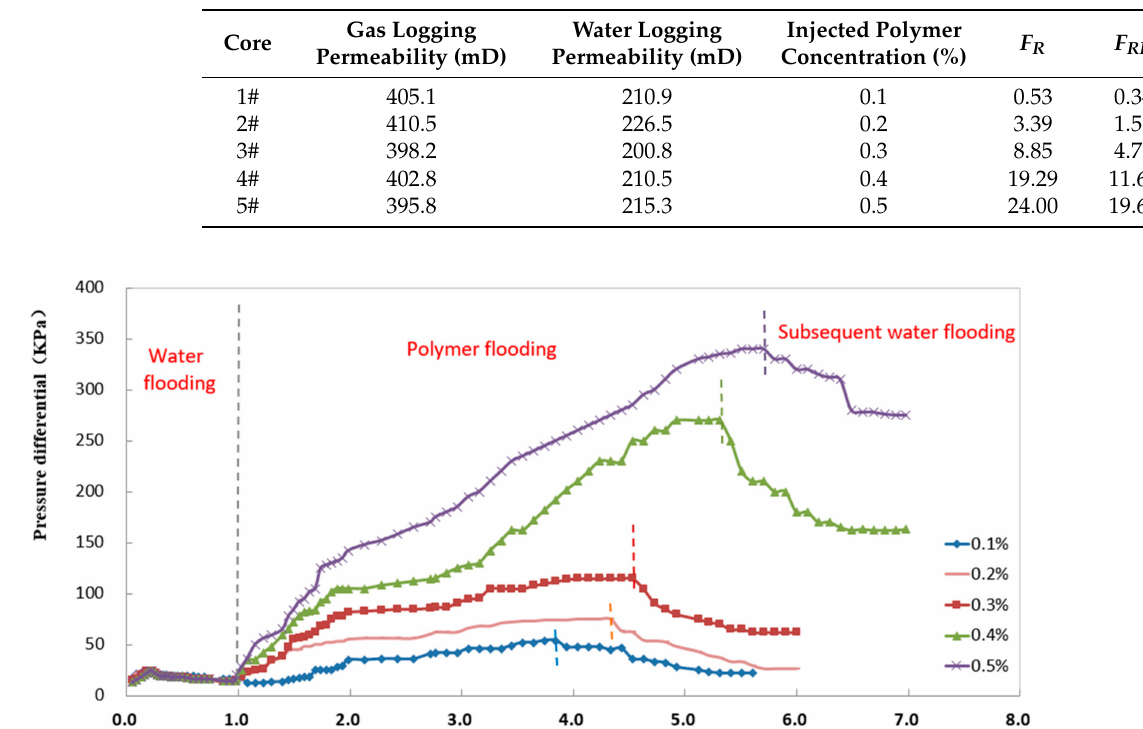
Table 3. Test results showing the F R and F RR values of the polymer solutions.